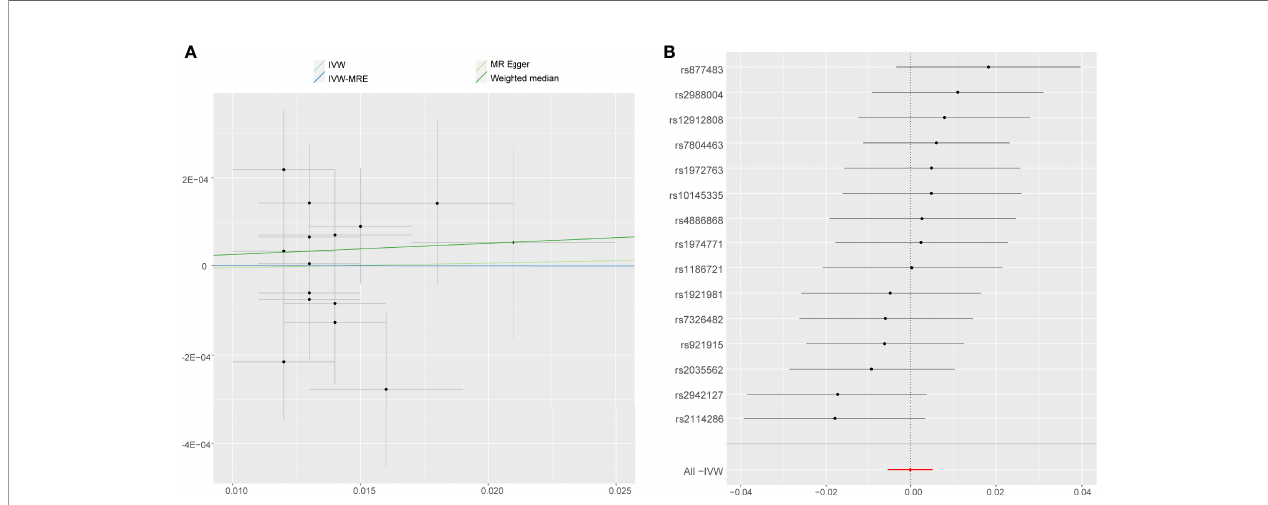
FIGURE 6 | Forest plot and scatter plot of the association of self-reported moderate-to-vigorous PA with the risk of AS. (A) Scatter plot: each black dot indicates a SNP, plotted by the estimate of SNP on self-reported moderate-to-vigorous PA and the estimate of SNP on the risk of AS with standard error bars. The slopes of the lines correspond to causal estimates using each of the different methods. (B) Forest plot: the dot and bar indicate the causal estimate of self-reported moderate- to-vigorous PA on risk of